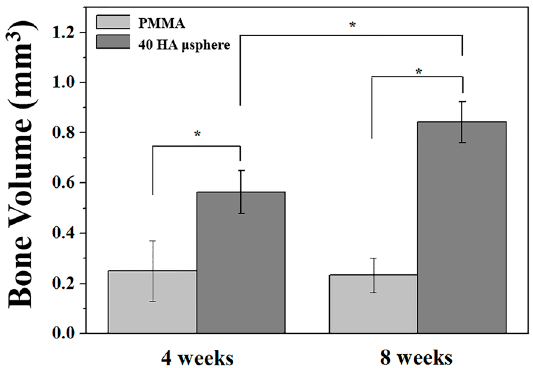
Figure 12 . Volumes of bone tissues newly formed around and within PMMA and PMMA/HA composite with an HA content of 40 vol % after 4 and 8 weeks of implantation (* p < 0.05).